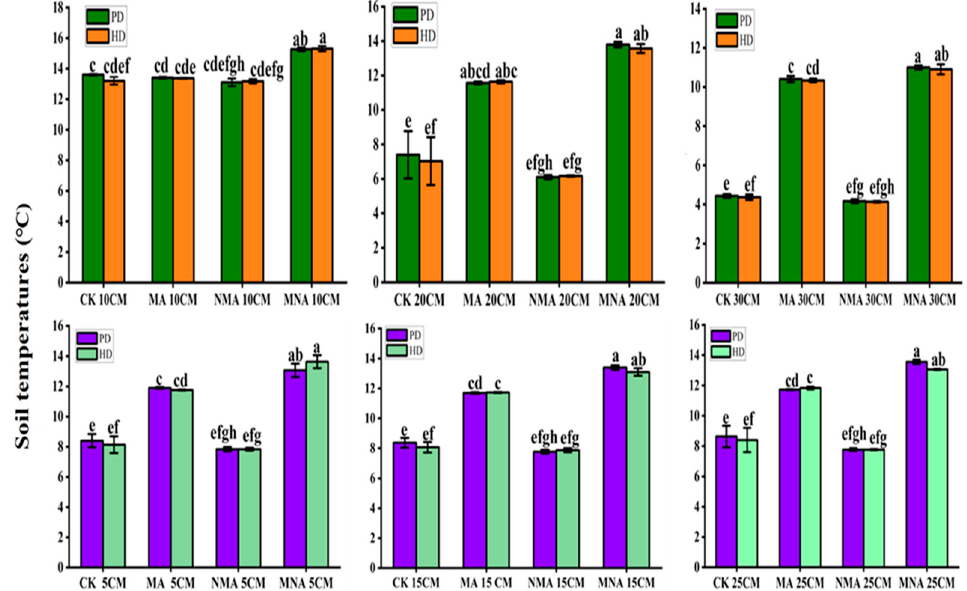
Figure 3. Effects of soil depth ( top row ) and distance from plant trunk ( bottom row ) on soil temperature. The bars are the standard error of the replications while the different letters on the bars indicate significant differences at p < 0.05.